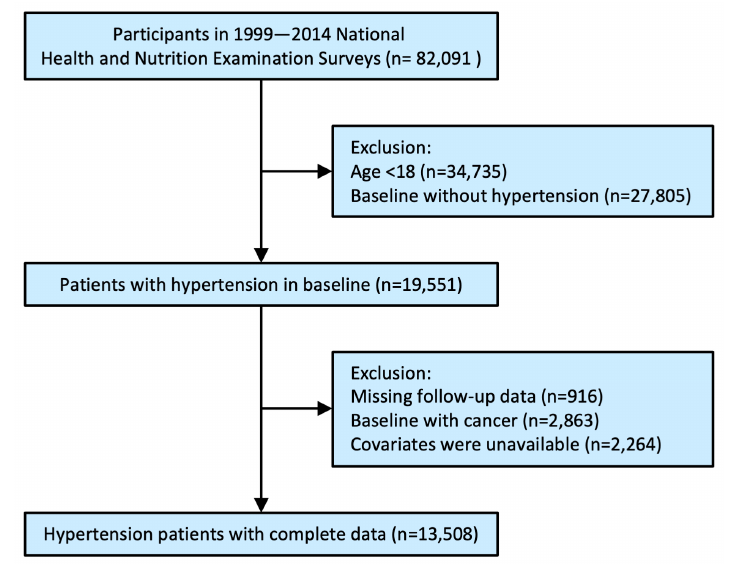
Figure 1. Study Figure 1. Study flowchart.